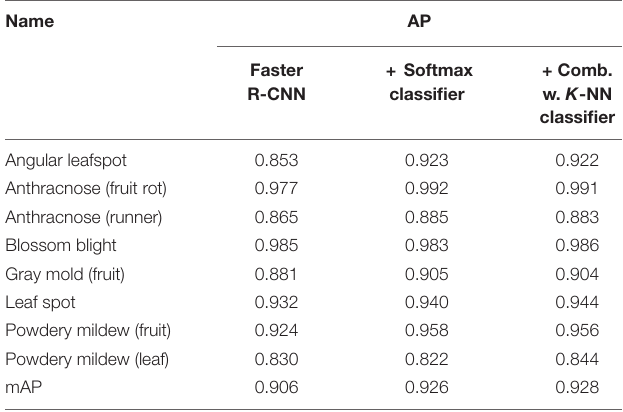
TABLE 3 | Final results of known disease detection for the test data.